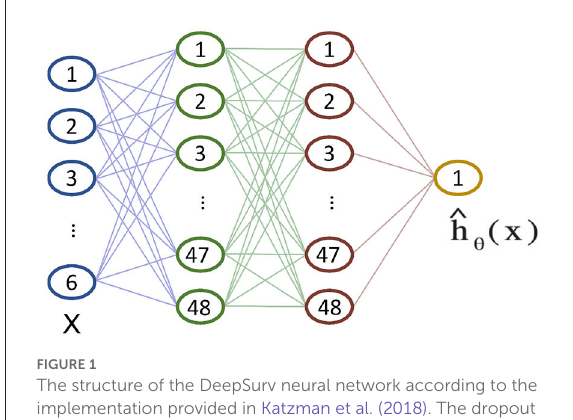
FIGURE1 The structure of the DeepSurv neural network according to the implementation provided in Katzman et al. (2018). The dropout layers between inputs and hidden layers are not shown for